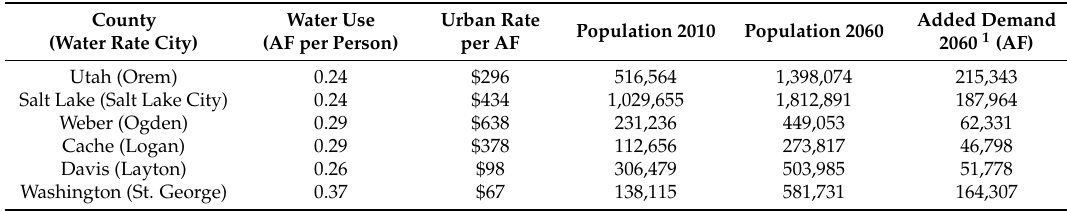
Table 6. Projected population and water